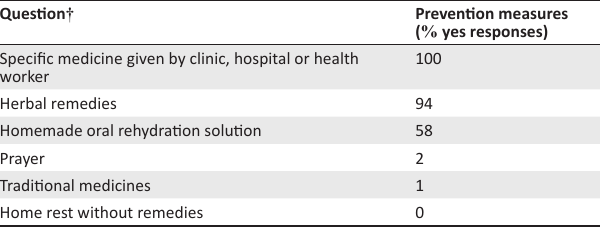
TABLE 5: Respondents’ knowledge of cholera treatment.